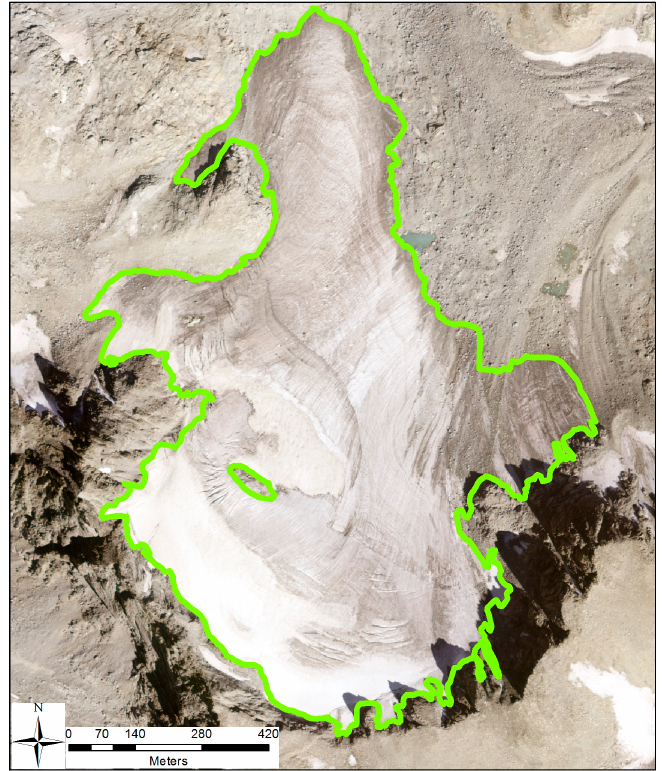
Figure 2. Delineation of Knife Point Glacier for